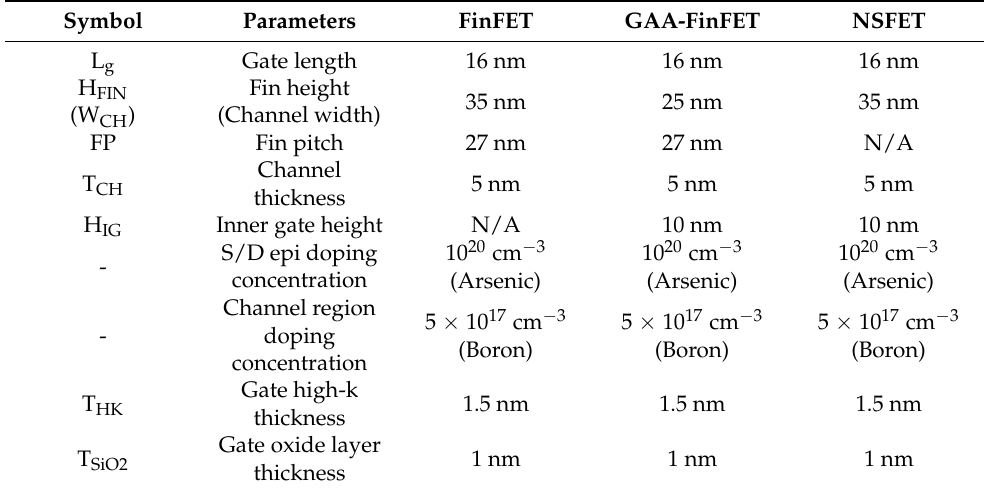
Figure 3. ( a ) Bird’s-eye and ( b , c ) cross-sectional views of nano-sheet FET (NSFET). The geometric device parameters are noted in the figures. The height of each inner gate (H IG ) is 10 nm. The length of the inner gate is defined as the gate length (L g ) plus the proximity. The channel width (W CH ) of each nano-sheet is 35 nm. Table 1. Simulation parameters of the device structures in this